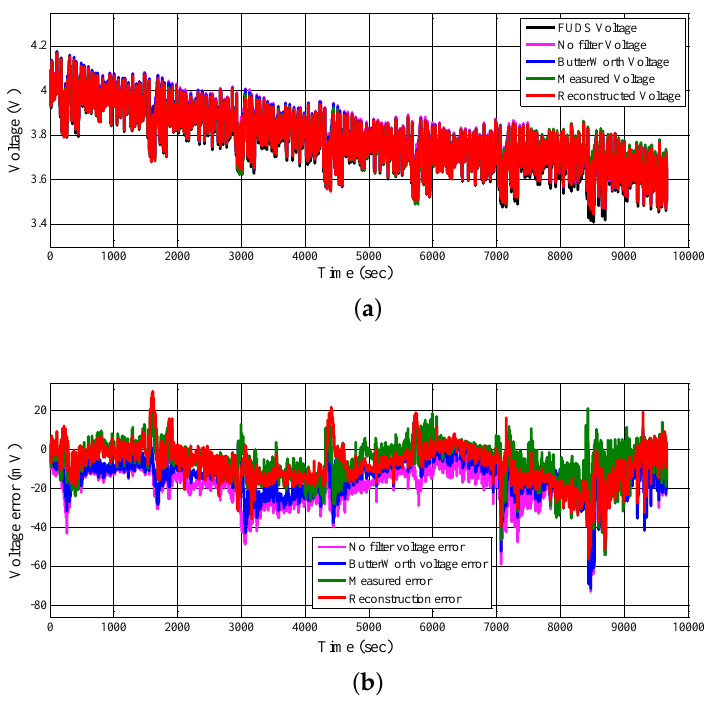
Figure 10. Simulated voltage results and errors under FUDS test at 25 ◦ C. ( a ) Comparison of the FUDS voltage and simulated voltages under FUDS test. ( b ) Simulated voltage errors with different methods under FUDS test.